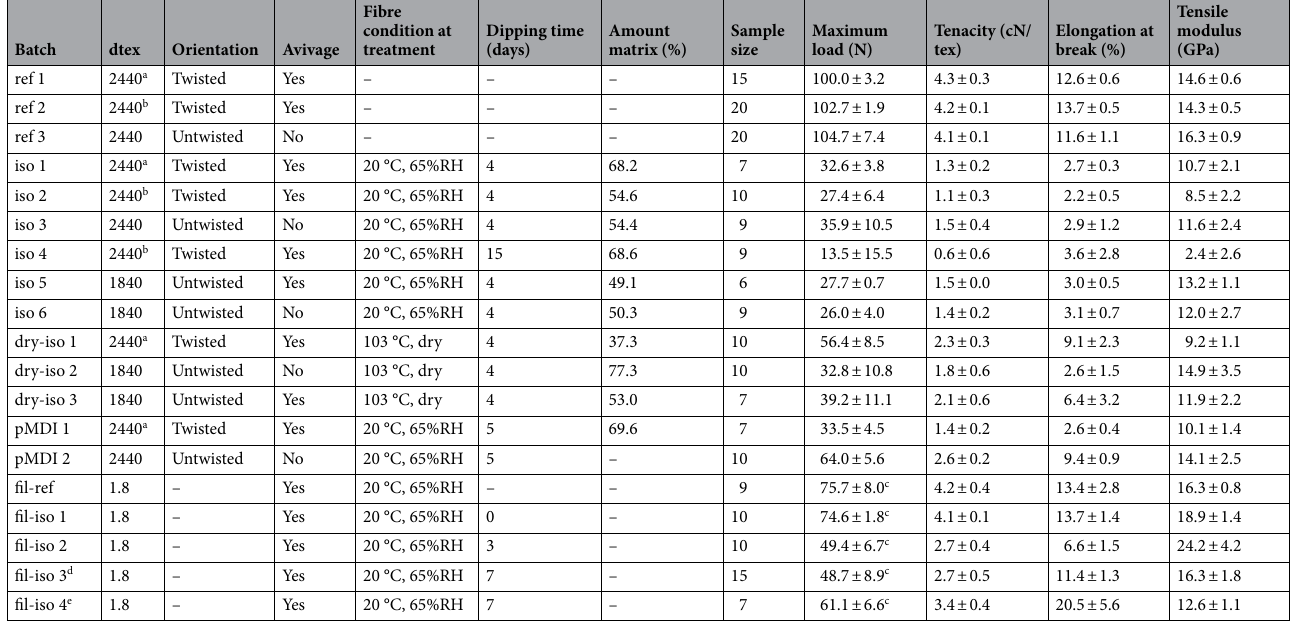
Table 1. Processing conditions for the preparation of isocyanate-treated viscose yarns and results from tensile tests (mean values ± standard deviation). a Warp yarn from fabric. b Weft yarn from fabric. c Displayed unit mN.